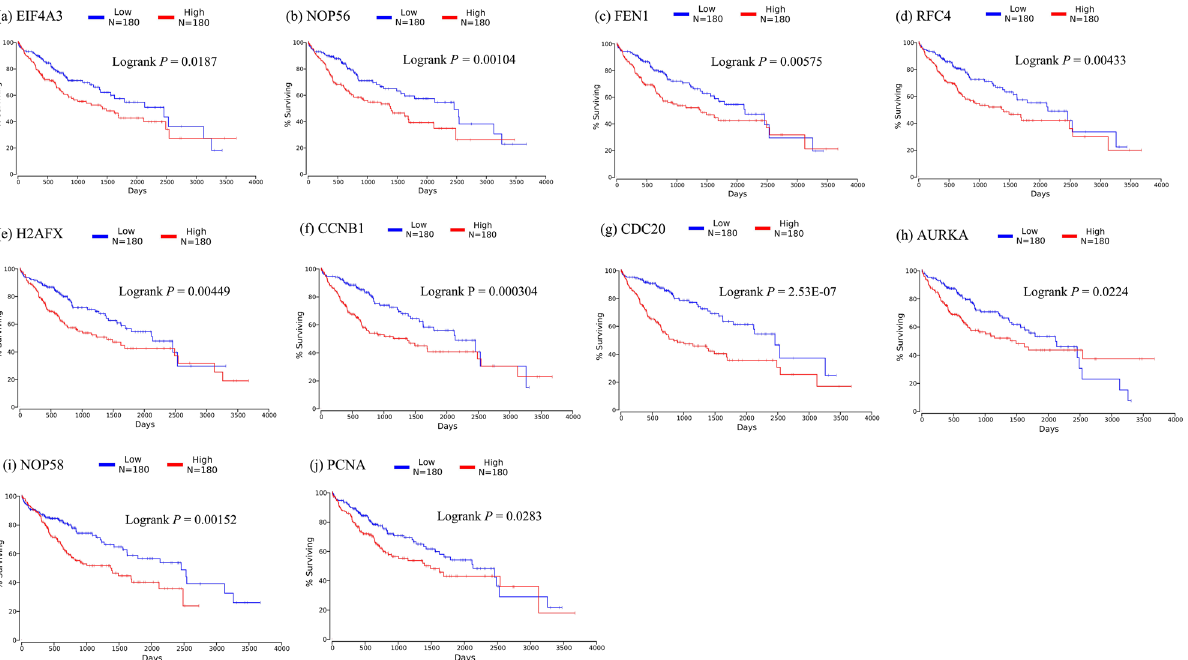
Figure 6. Significant correlation between key genes expression and survival. Survival curves of key genes identified by GCNA-kpca algorithm. X-axis represents survival time and Y-axis represents survival rate. This figure was drawn with OncoLnc 19 (http://www.oncol